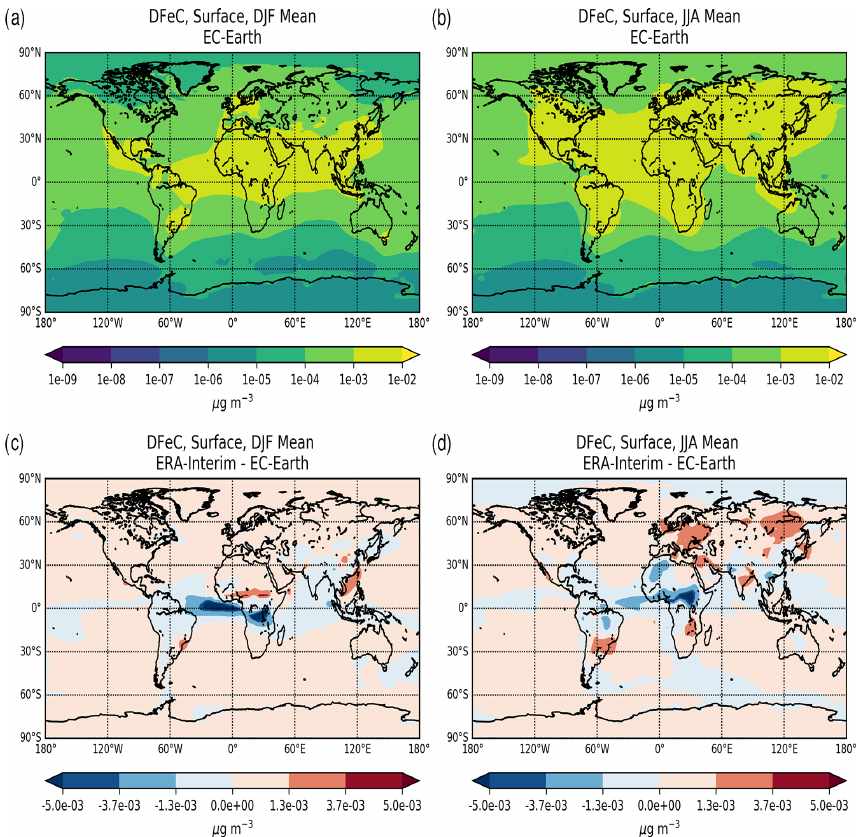
Figure 8. Dissolved iron surface concentrations (µgm − 3 ) from combustion aerosols (DFeC) for the boreal winter (DJF; a ) and summer (JJA; b ) seasons for the EC-Earth simulation, averaged for the period 2000–2014, and the respective absolute differences to the ERA-Interim simulation (c, d)